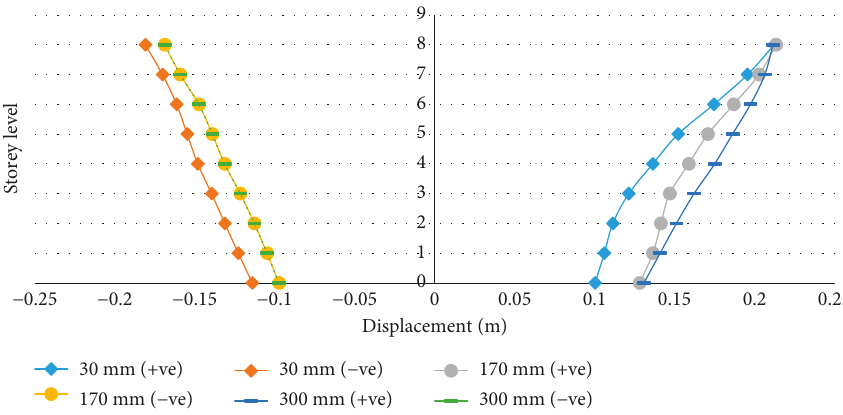
Figure 19: Envelope displacement response of the tall BI buildings considering different seismic